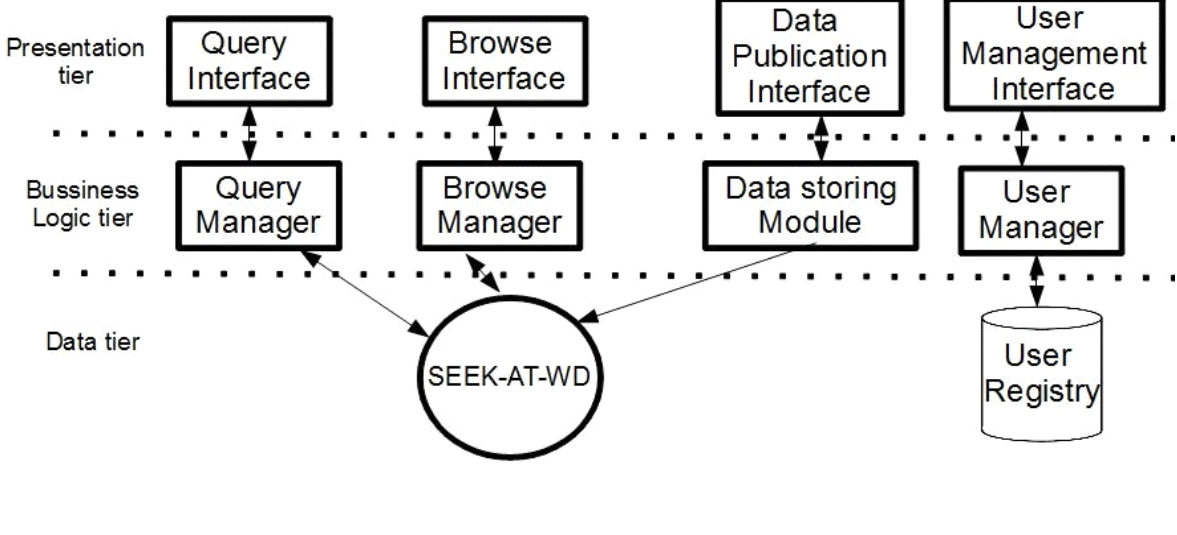
Figure 2. Logical architecture of